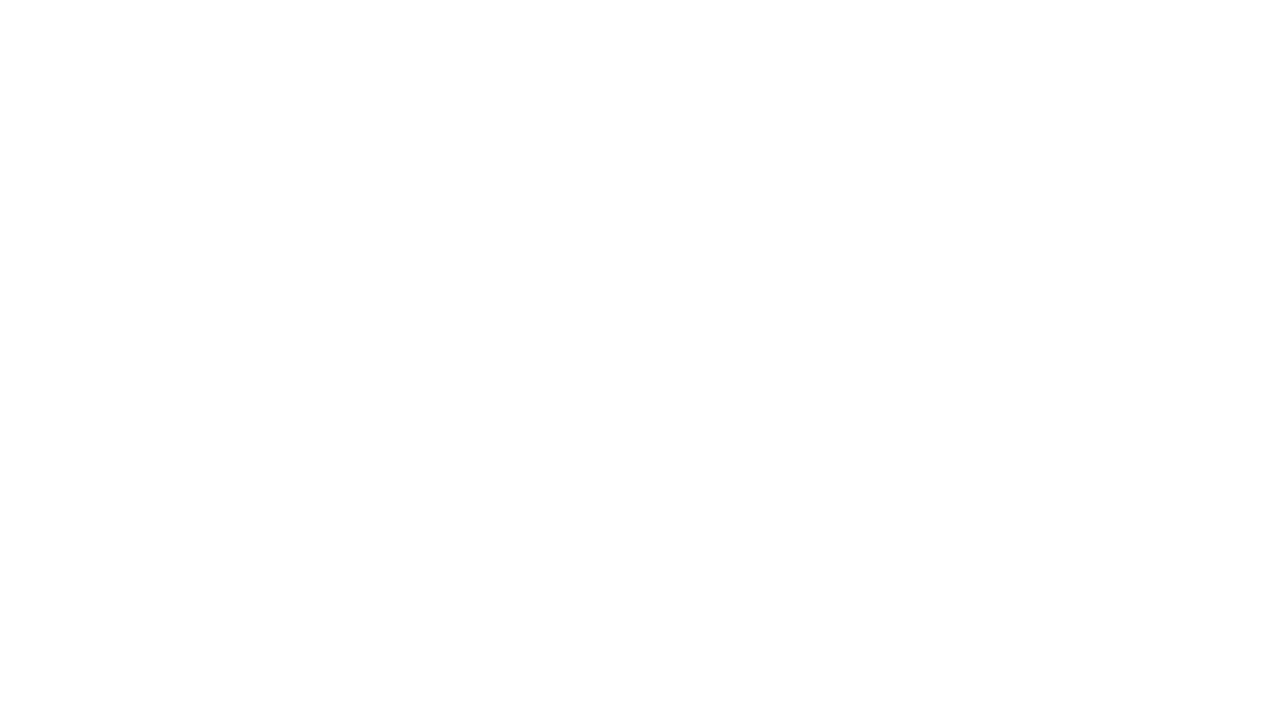
Frontiers in Cell and Developmental Biology | www.frontiersin.org